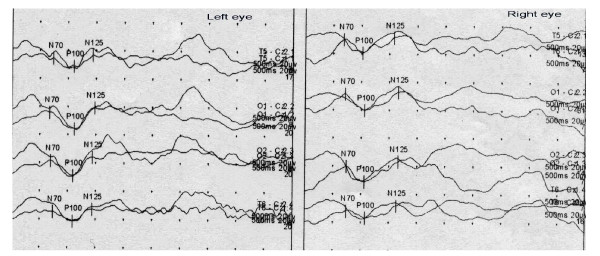
Visual evoked potential on Oct. 12, 2011: Flash stimulation tests were performed on both eyes. The VEP results showed that the waveforms of both eyes were well differentiated, the fundus was slightly wider, P100 amplitude increased obviously and the P100 latency was essentially normal.